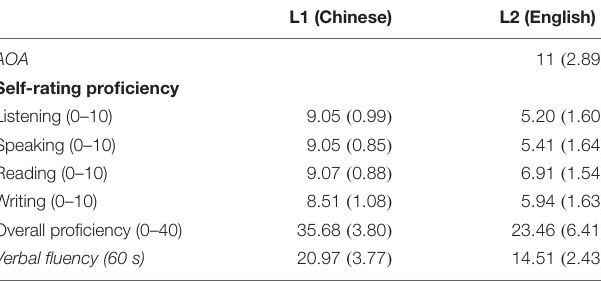
TABLE 1 | Language background of participants: age of acquisition (AoA), scores of self-rated proficiency (0 as the minimum and 10 as the maximum) and the verbal fluency